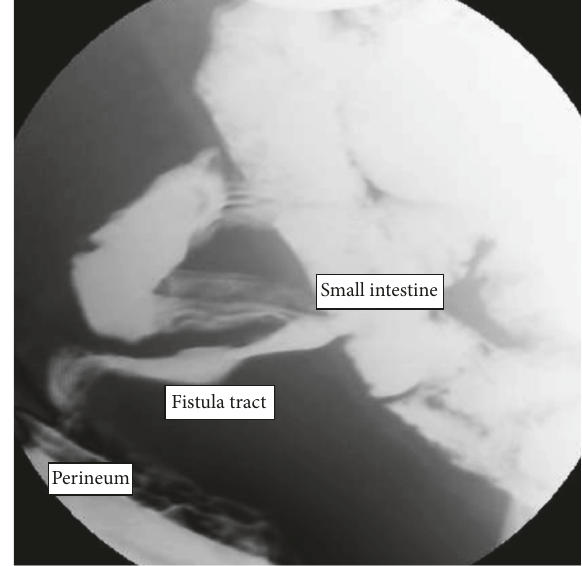
Figure 1: Sagittal view MRI of pelvis demonstrating 7 × 3cm tract from perineum to presacral space.